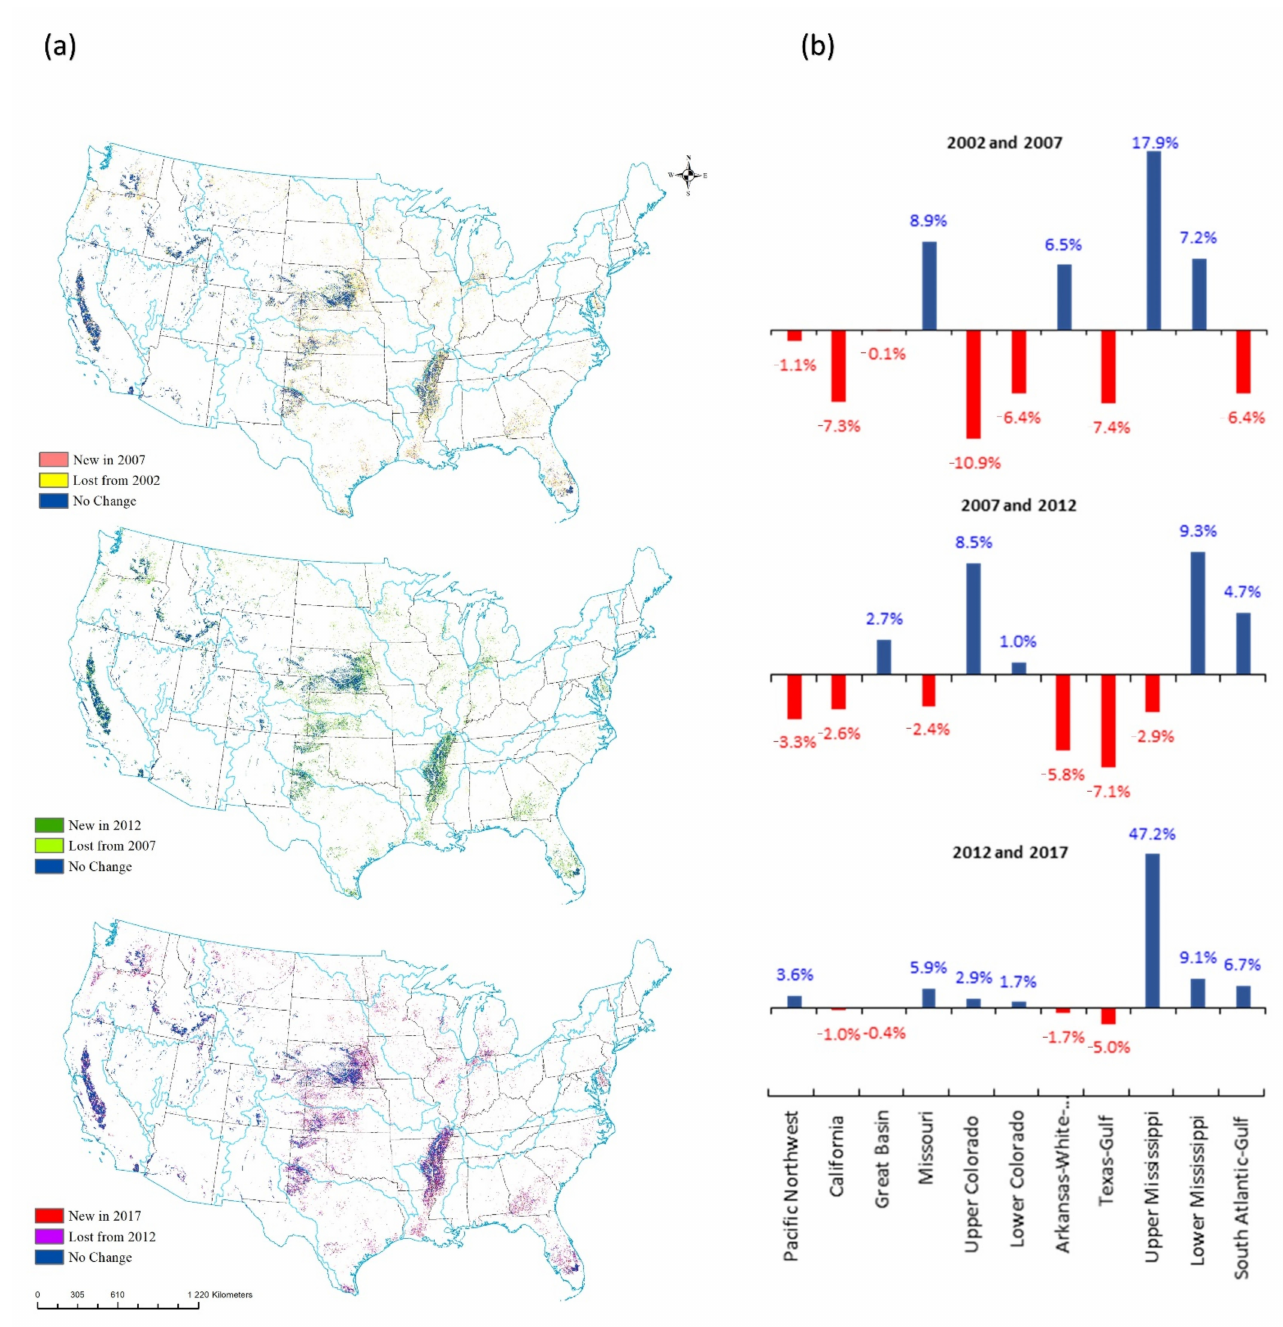
Figure 2. MIrAD-US: Irrigation Dynamics across all intervals, ( a ) graphics showing CONUS-wide proportional irrigation gain and loss and ( b ) column charts showing watershed-wide irrigation gain and loss at 5 years mapping